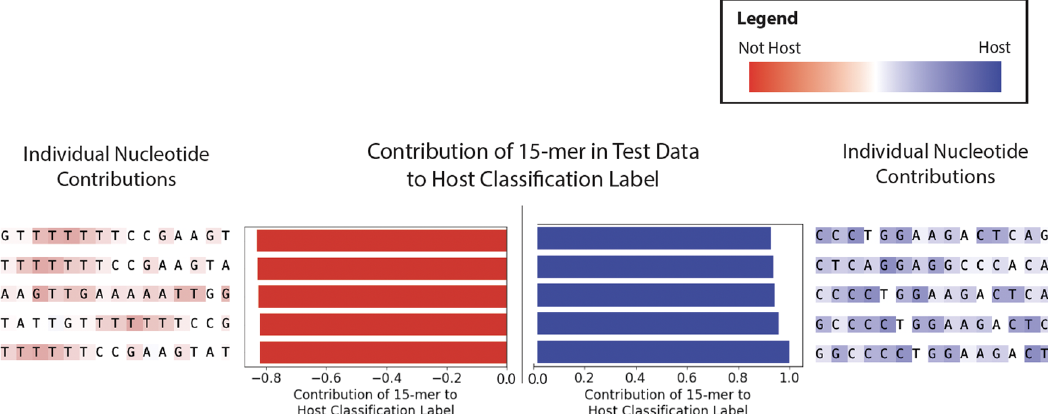
Fig. 6 15-mers that most and least contributed to AMAISE ’ s host classi fi cation label. The horizontal bar graphs represent the overall contribution of 15- mers to AMAISE ’ s classi fi cation decision. The fi ve 15-mers with the highest impact on the decision for each class, “ not host ” (or “ microbe ” ) (to the left) and “ host ” (to the right), are shown with their nucleotide sequences. Each nucleotide in the sequence is highlighted with a color/darkness indicating their individual impact towards a classi fi cation decision, red for microbial, blue for host classi fi cation, and dark for increased impact. Based on the individual impact of the nucleotides highlighted in red, we found that the 15-mers that most contributed to a microbial classi fi cation label contained at least one ‘ CG ’